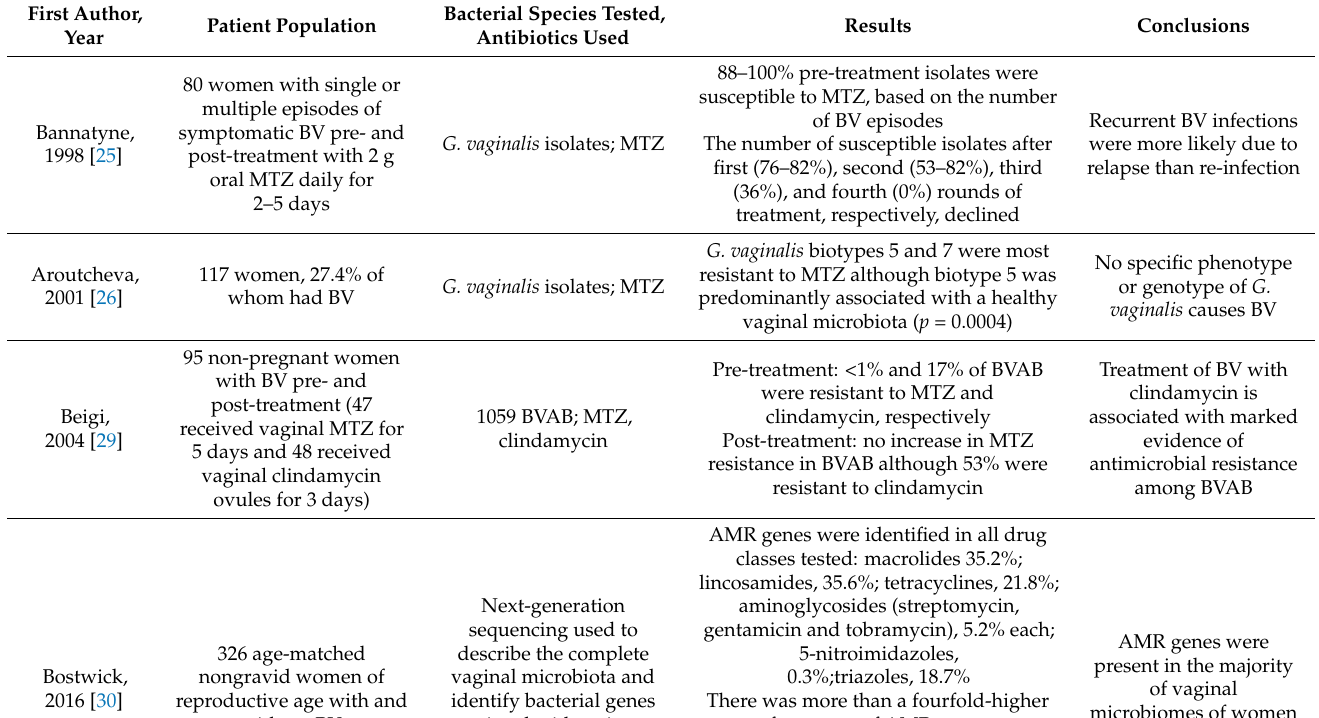
Table 2. In vivo data on antibiotic drug resistance in BV-associated